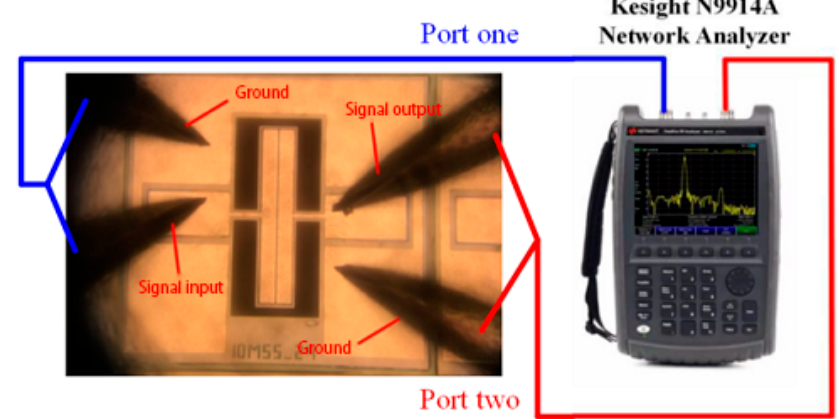
Micromachines 2020 , 11 , x FOR PEER REVIEW Figure 8. Schematic diagram of the measurement platform. Figure 8. Schematic diagram of the measurement platform.